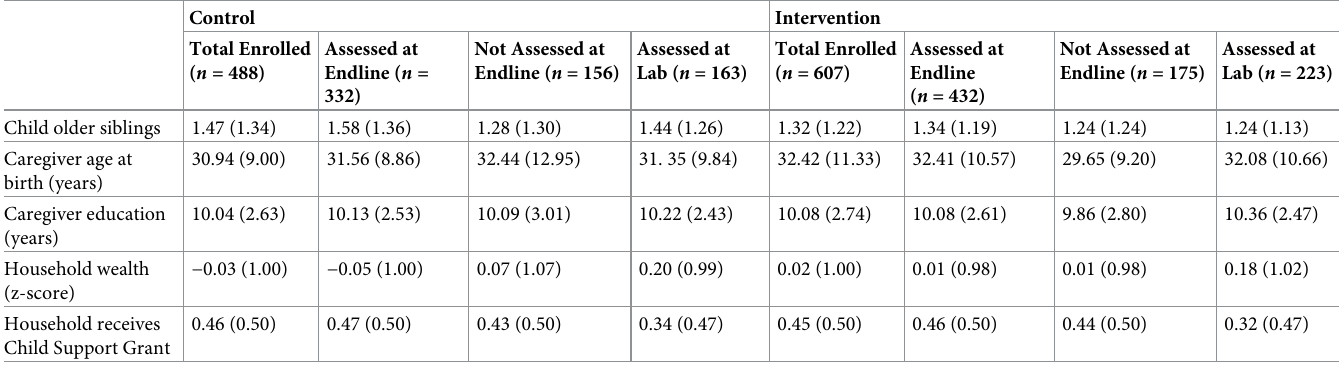
Table 1. Characteristics of study